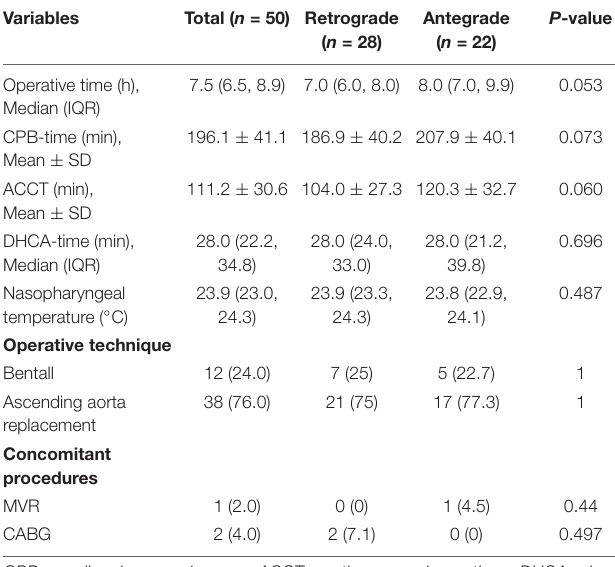
of proximal stent landing in the antegrade and retrograde TABLE 3 | Intraoperative